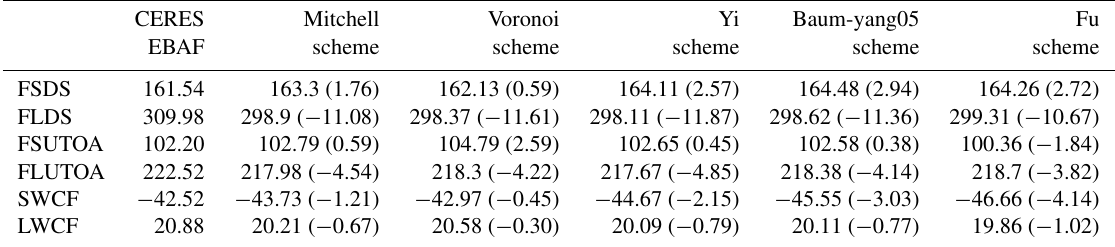
Table 2. TOA upwelling and downwelling surface fluxes (Wm − 2 ) and TOA SWCF and LWCF (Wm − 2 ) for the five schemes compared with CERES EBAF products. Numbers in parentheses are differences between the five scheme simulations and CERES EBAF